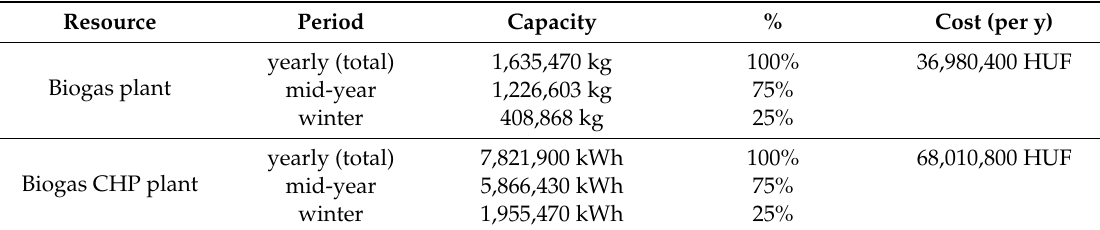
Table 11. Utilization of the plant producing biogas, and the CHP power plant producing energy, according to the optimal solution of the multi-periodic model with 20 years investment horizon assumed. Resource